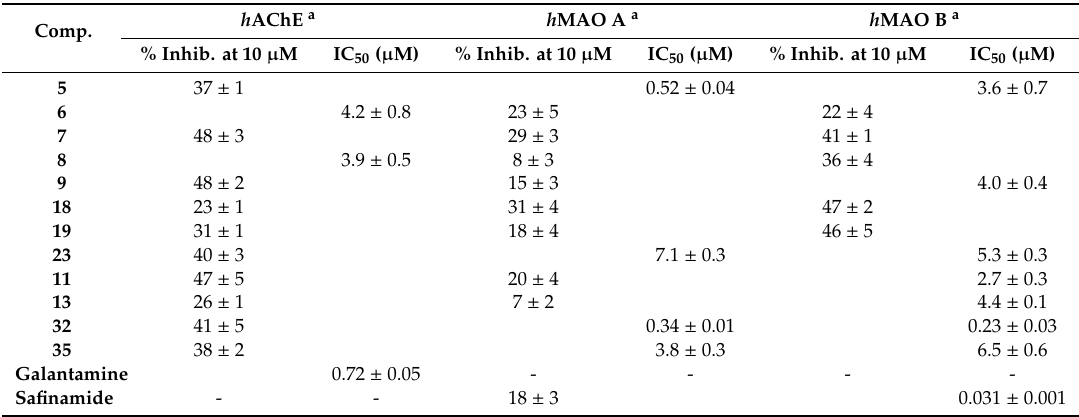
Table 6. Inhibition data of acetylcholinesterase and monoamine